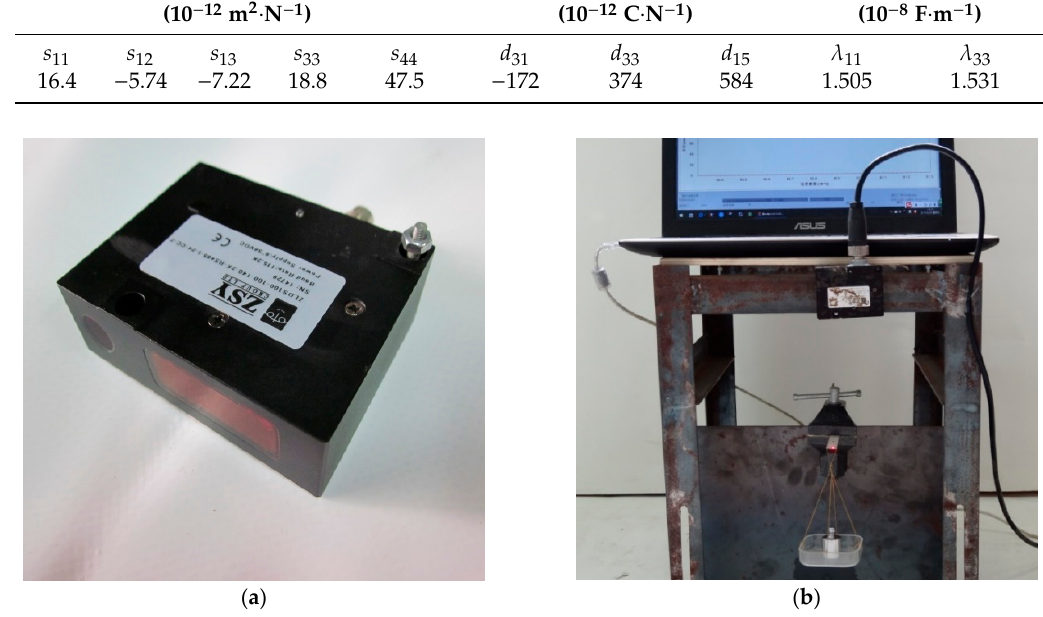
Figure 3. Scheme of the measuring instruments and experimental device: ( a ) the non-contact laser displacement sensor; ( b ) the integral measuring device. Table 1. Physical properties of the PZT-5 materials [27].